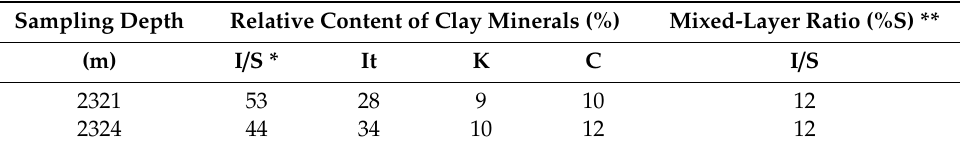
*TOC represents the total organic carbon of the tested samples. Table 2. Clay minerals composition of shale samples. Table 2. Clay minerals composition of shale samples.